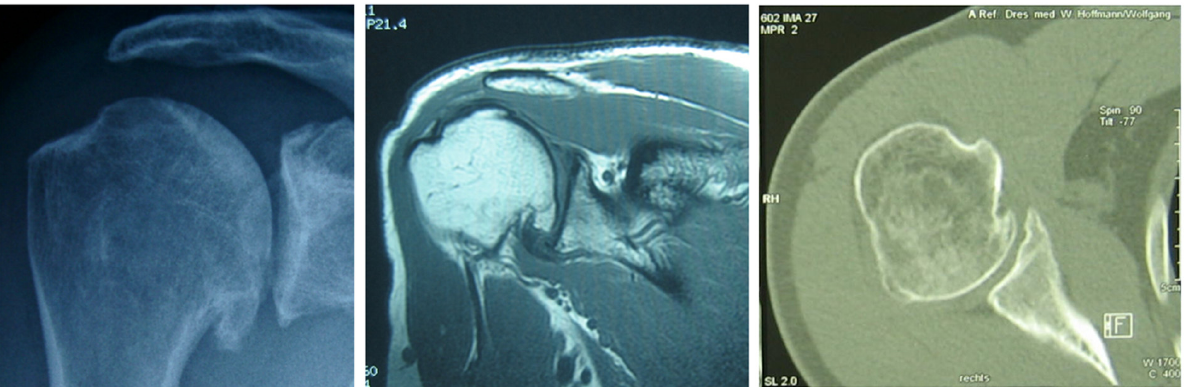
Figure 1. Imaging methods for evaluating dislocation arthropathy. Examples of conventional radiographs, MRI, and CT scan showing OA.